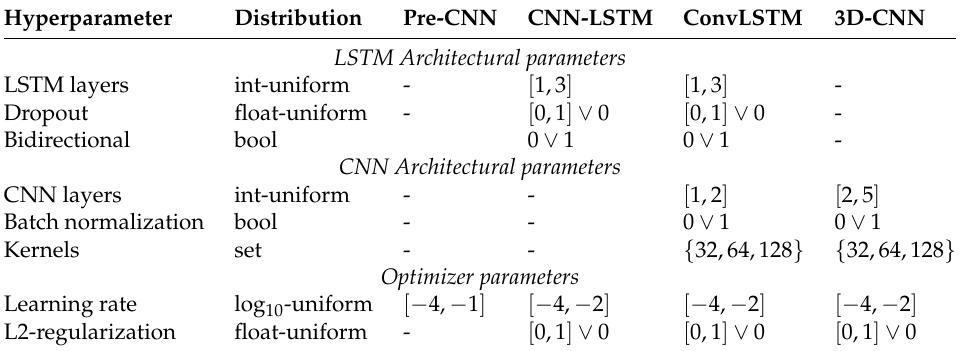
Table 3. The model-specific hyperparameters and their distributions tuned during the random search. Square brackets indicate closed interval with lower and upper limit included, while curly brackets indicate a set from which a value was chosen from. The presence of ∨ indicates a boolean toggle with p = 0.5. The log 10 -uniform distribution used for the learning rate draws a value a from a float-uniform distribution in a given range to calculate 10 a